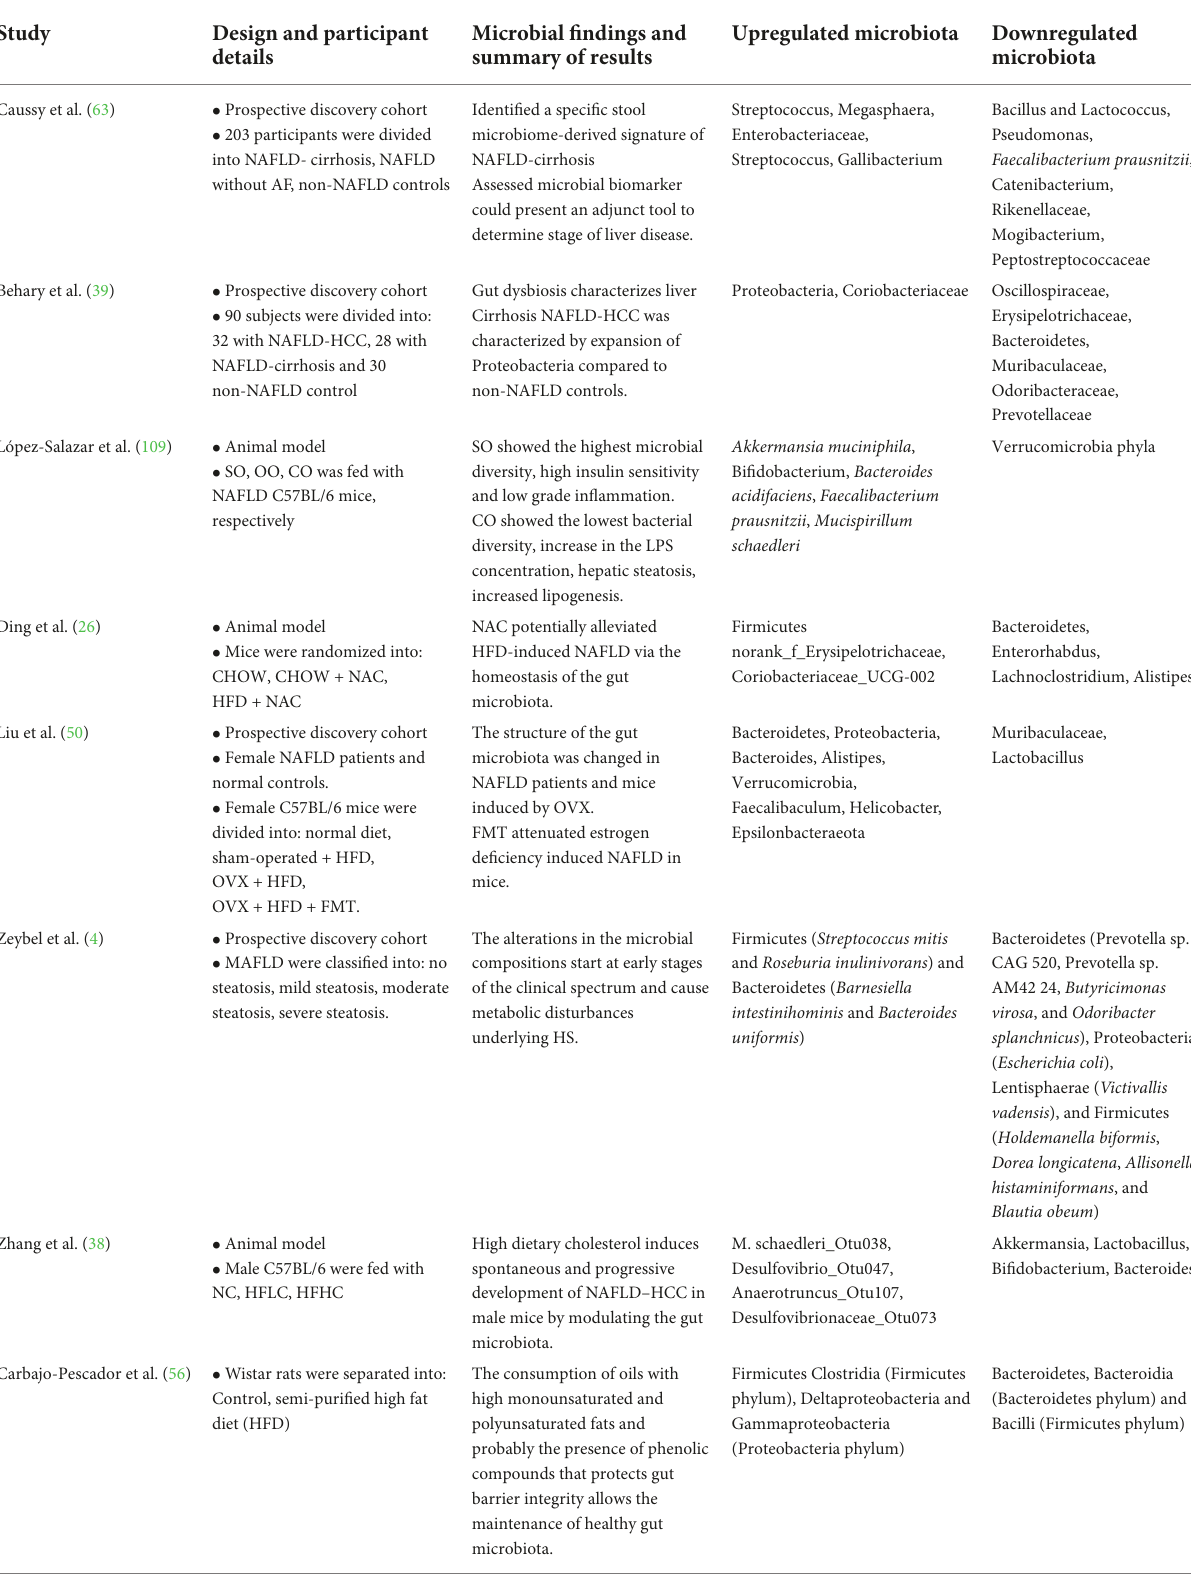
TABLE 1 Investigations into NAFLD and microbiota composition and function in